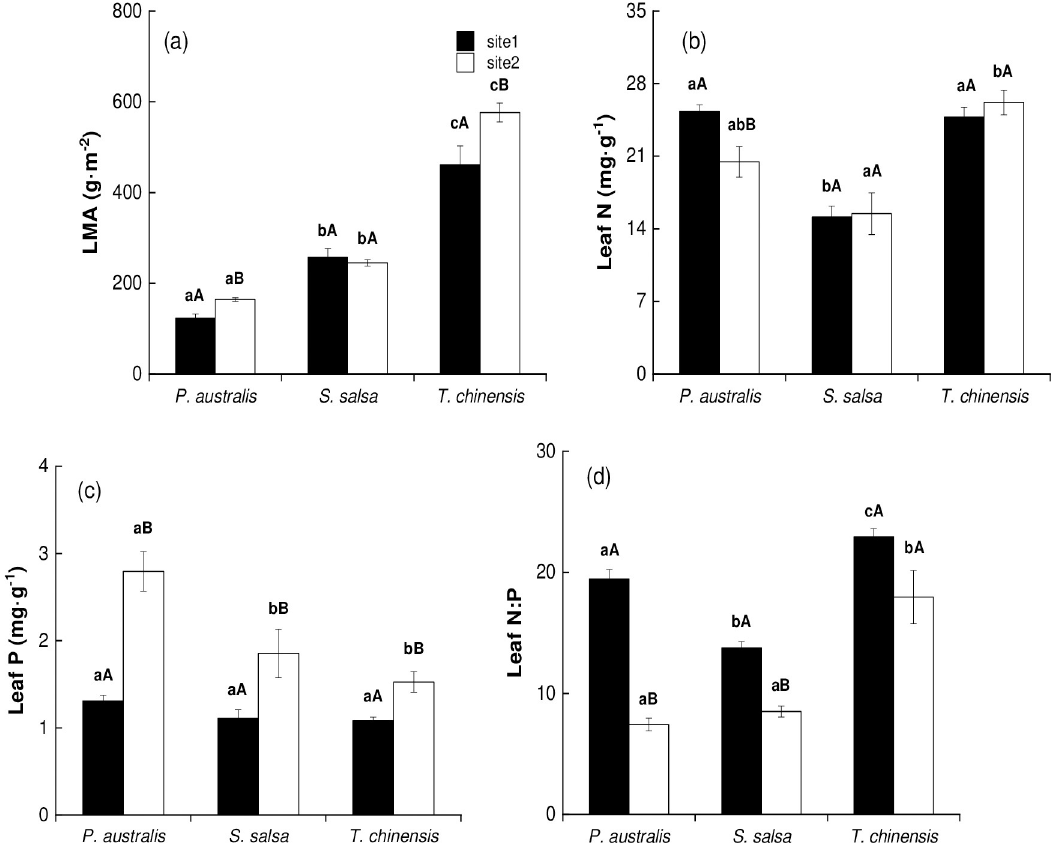
Fig 2. Leaf mass per area (LMA) and leaf nutrient conditions (mean ± SE) of halophytic plant communities. (a) LMA, (b) leaf N, (c) leaf P, and (d) leaf N:P. The different lower letters indicate significant differences ( P < 0.05) between the different species in the same site; the different upper letters indicate significant differences ( P < 0.05) between the same species in different sites.